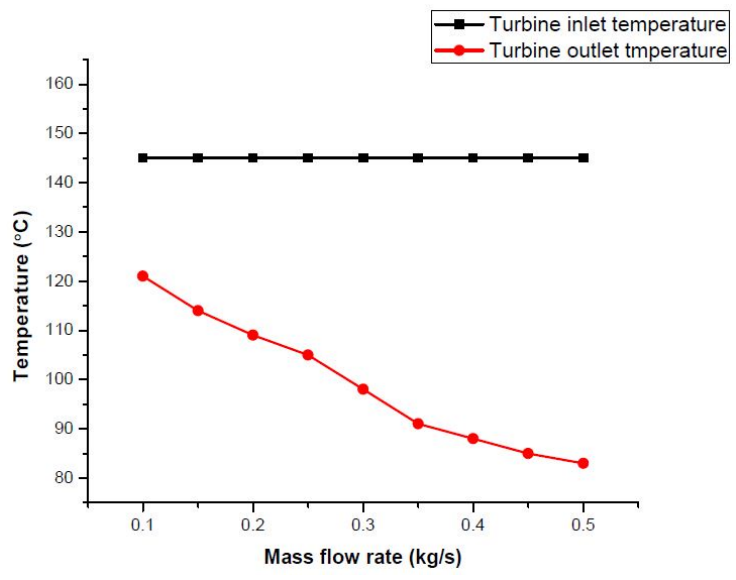
Figure 5. Variation of turbine outlet temperature with mass flow rate of the working fluid.